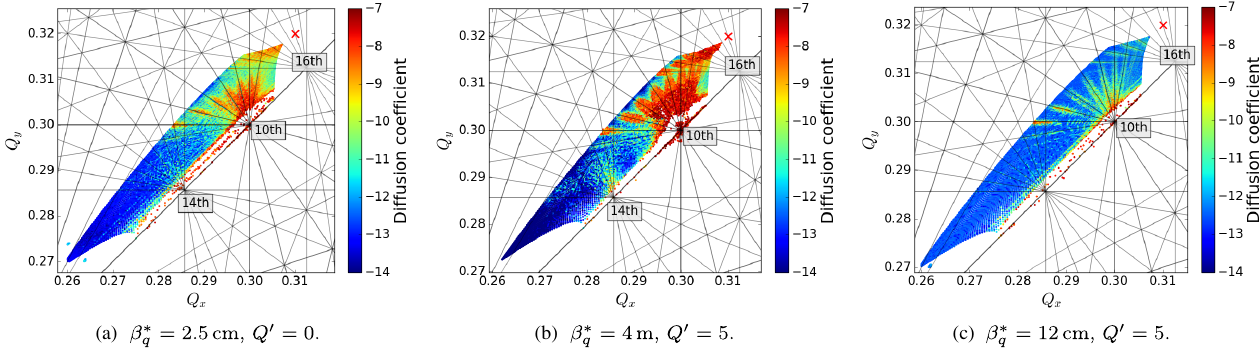
FIG. 19. FMAs illustrating the effect of synchrobetatron resonances due to the hourglass effect, for a working point of ð Q x ; Q y Þ ¼ ð 0 . 31 ; 0 . 32 Þ and ξ Tot ¼ 0 . 05 , related to the beam quality study in Fig. 18. Possible resonance lines up to the 16th order have been added, including a few labels meant to guide the